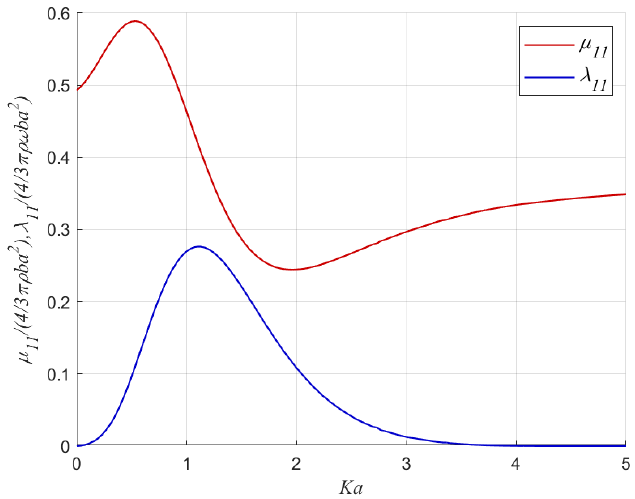
Figure 6. Normalized hydrodynamic coefficients in surge for a/b = 1.25, f = 1.01a and h = 5a.